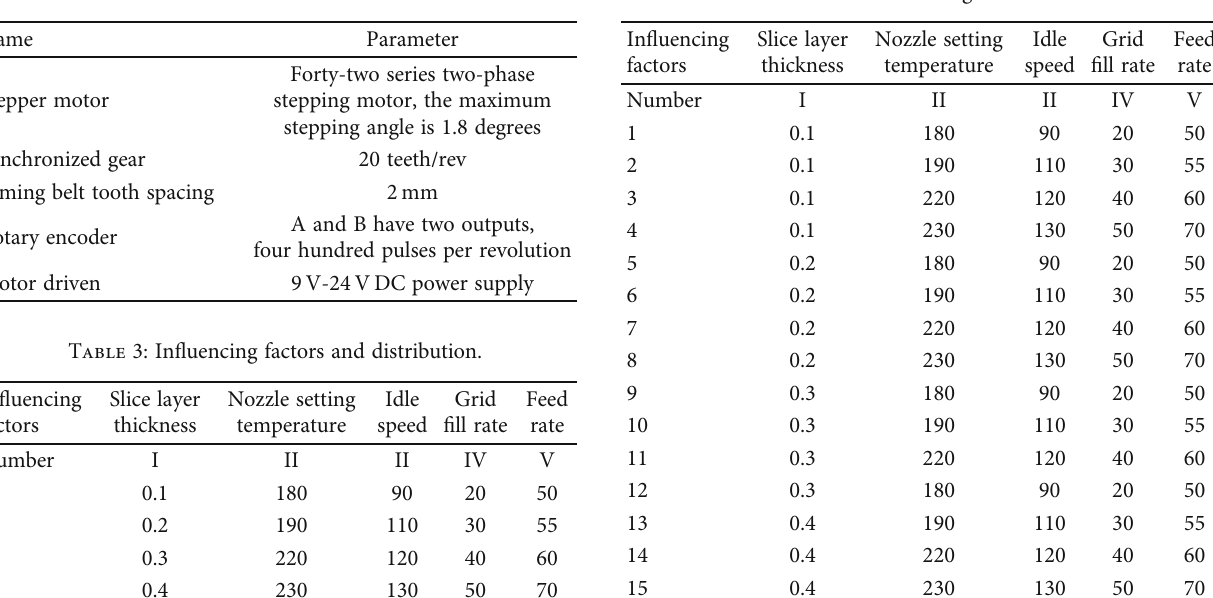
Table 4: Five-factor four-level orthogonal distribution test table.